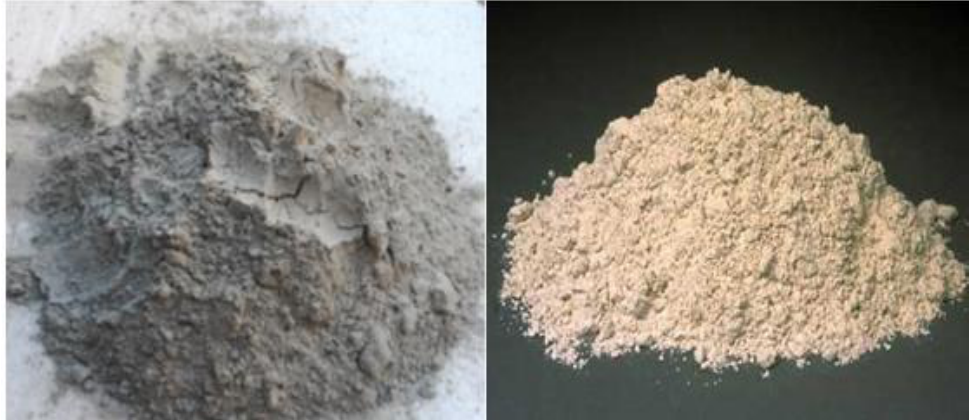
Figure 2. The FA and SG used in the study. Table 1. The chemical composition of QRD, SG, and FA from XRF analysis.